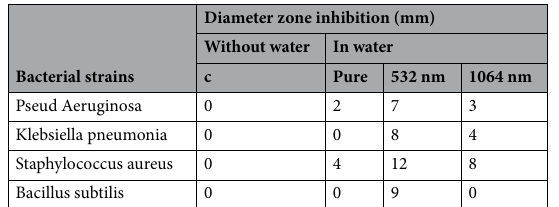
Diameter zone inhibition (mm) Without water In